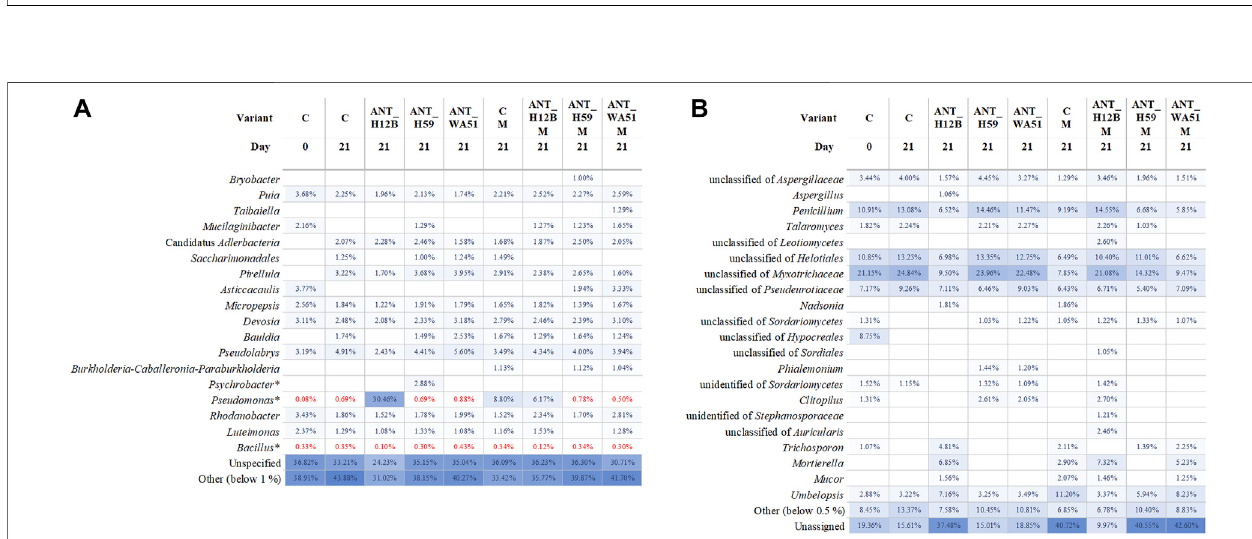
FIGURE 7 | Bacterial (A) and fungal (B) diversity based on V3-V4 of 16S rRNA and ITS2 amplicons analysis. The diversity was presented on the genus level when possible, otherwise, the last speci fi c taxon level name was used. For the clarity of the fi gure, only taxa with abundance over 1% or 0.5% for Bacteria and Fungi , respectively, are shown. Taxa with abundances below thresholds are presented as the “ Other ” group. ASVs that were not classi fi ed or were classi fi ed with not speci fi c taxonomicnamesarepresentedas “ Unassigned ” or “ Unspeci fi ed ” groups,respectively.Inthecaseof Psychrobacter , Pseudomonas and Bacillus genera,alsothe abundance below the threshold was shown and marked in red. In the variant description, “ C ” and “ M ” are abbreviations of control samples and metabolites used for supplementation, respectively.